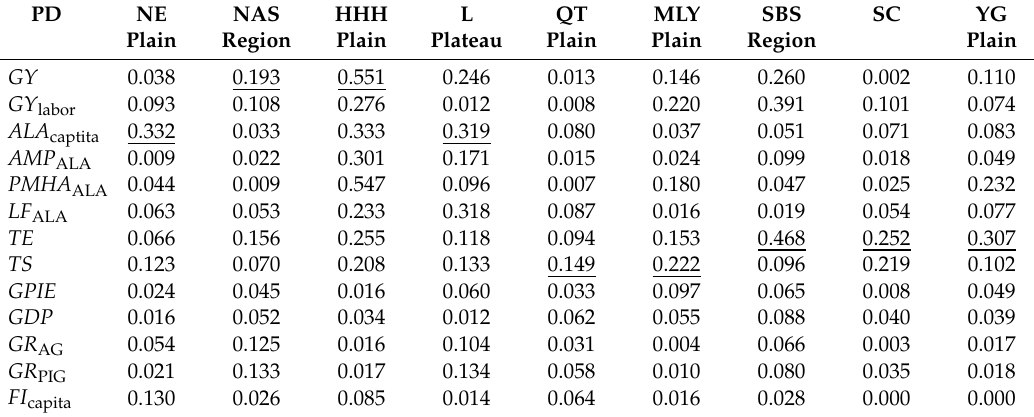
Table 4. The power of determinant (PD) values as derived from the Geo-Detector for the influence of 13 factors on cropping intensity. The maximum PD values for each region are